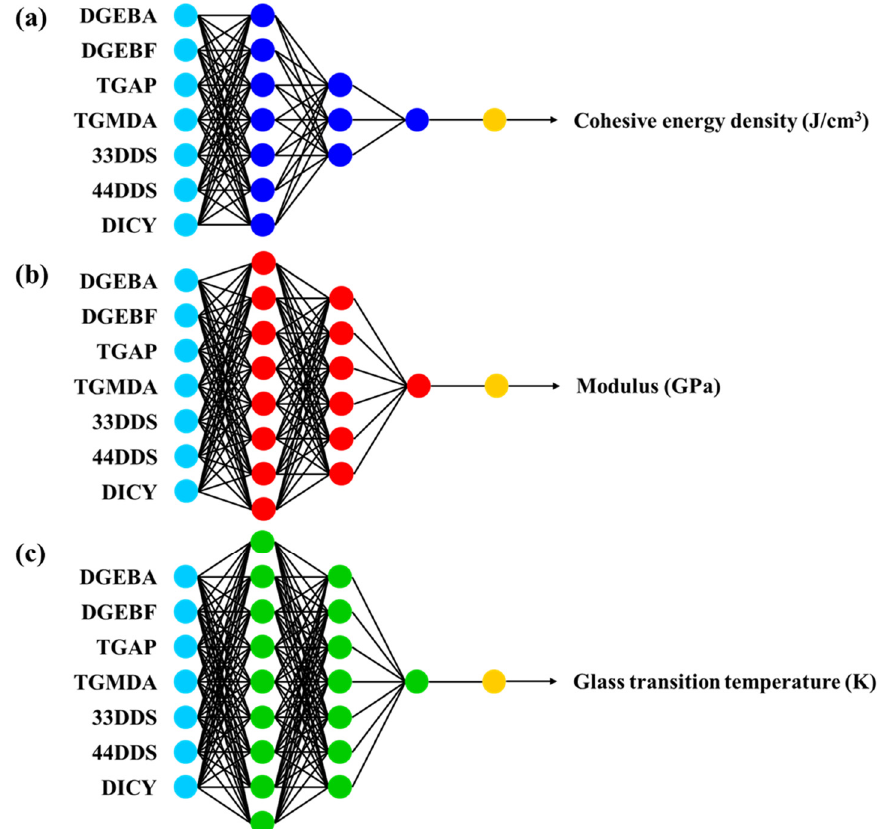
Figure 4. Artificial neural network (ANN) models for predicting ( a ) cohesive energy density, ( b ) modulus, and ( c ) glass transition temperature. The cyan circles of ANN models indicate neurons of input layer, and the blue, red and green circles show neurons of hidden layers. The yellow circles indicate neurons of output layer. Table 2. Root mean squared error (RMSE) and normalized squared error (NSE) on the training and test sets for predicting the cohesive energy, modulus, and glass transition temperature using the ANN model.